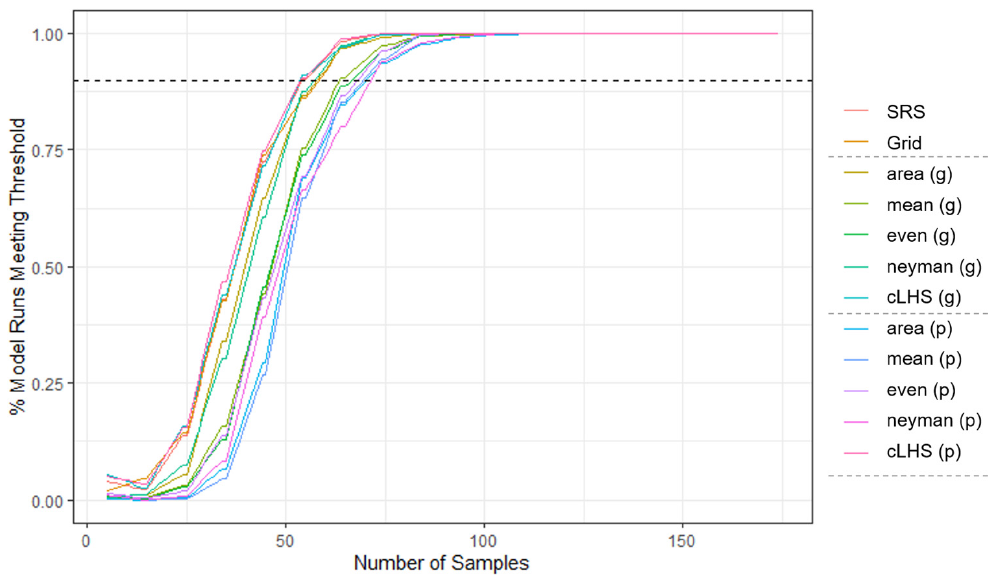
Figure 3. Monte Carlo Bootstrapping at OSG. Each line represents one of 12 different models and shows the percent of 500 model runs that meet the target threshold out of 500 model replicates. The dashed horizontal line sits at 90%.